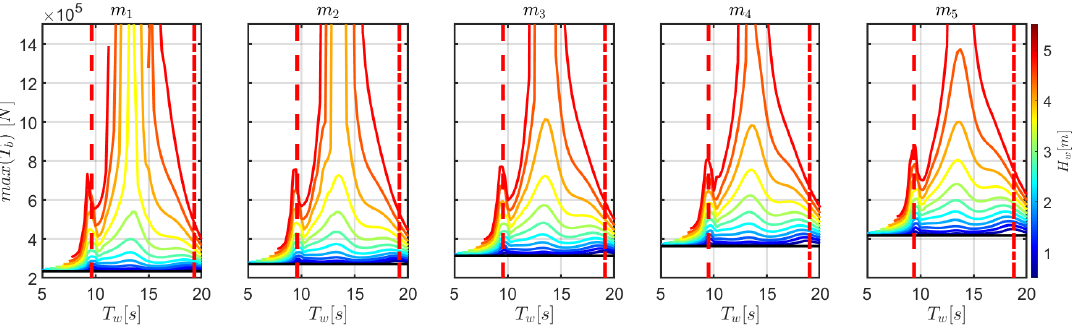
Figure 10. Peak tension of the front mooring at the fairlead as a function of T w , for different H w and for different mooring configurations, as tabulated in Table 3. The black line represents the pre-tension. The dashed and dash-dotted red lines correspond to T w = 1 T n ,5 and T w = T n ,5 , 2